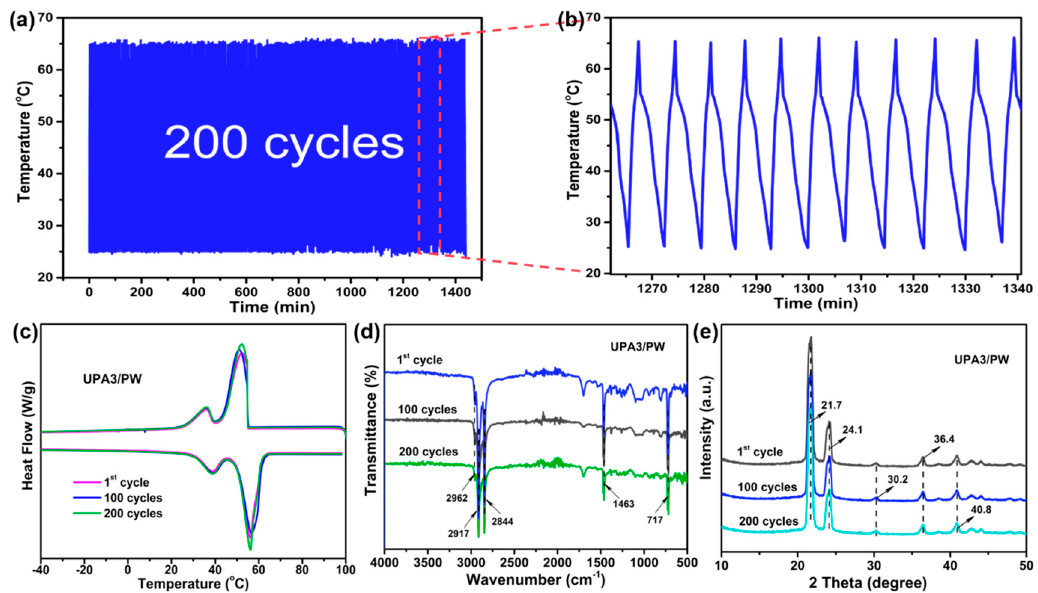
Figure 5. ( a , b ) Time–temperature evolution curves during 200 accelerated solar–thermal energy conversion cycling tests; ( c ) DSC curves, ( d ) FT–IR spectrum and ( e ) XRD patterns of the UPA3/PW before and after cycling tests.